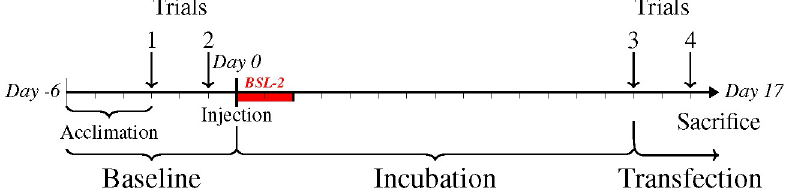
Fig 4. Experimental timeline with the injection of constructs on day 0. Fish were injected with a randomly assigned construct of either an aggression-related gene (AVP or MAOA) or a control fluorescent protein (EYFP). All trials were conducted double-blind to the transfected gene. Each trial had two respiration rate measurements followed by a territorial